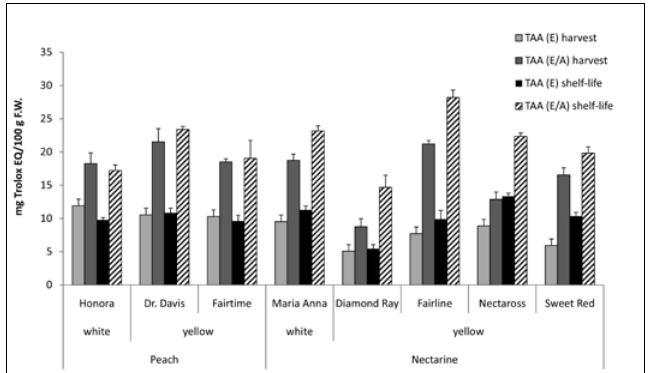
Fig. 3 - Total antioxidant activity (TAA) of ethanol/HCl (E) or ethanol/ acetone (E/A) extracts from flesh of different peach and nectar- ine cultivars at harvest and after five days of shelf-life at 20°C. Bars refer to standard error.